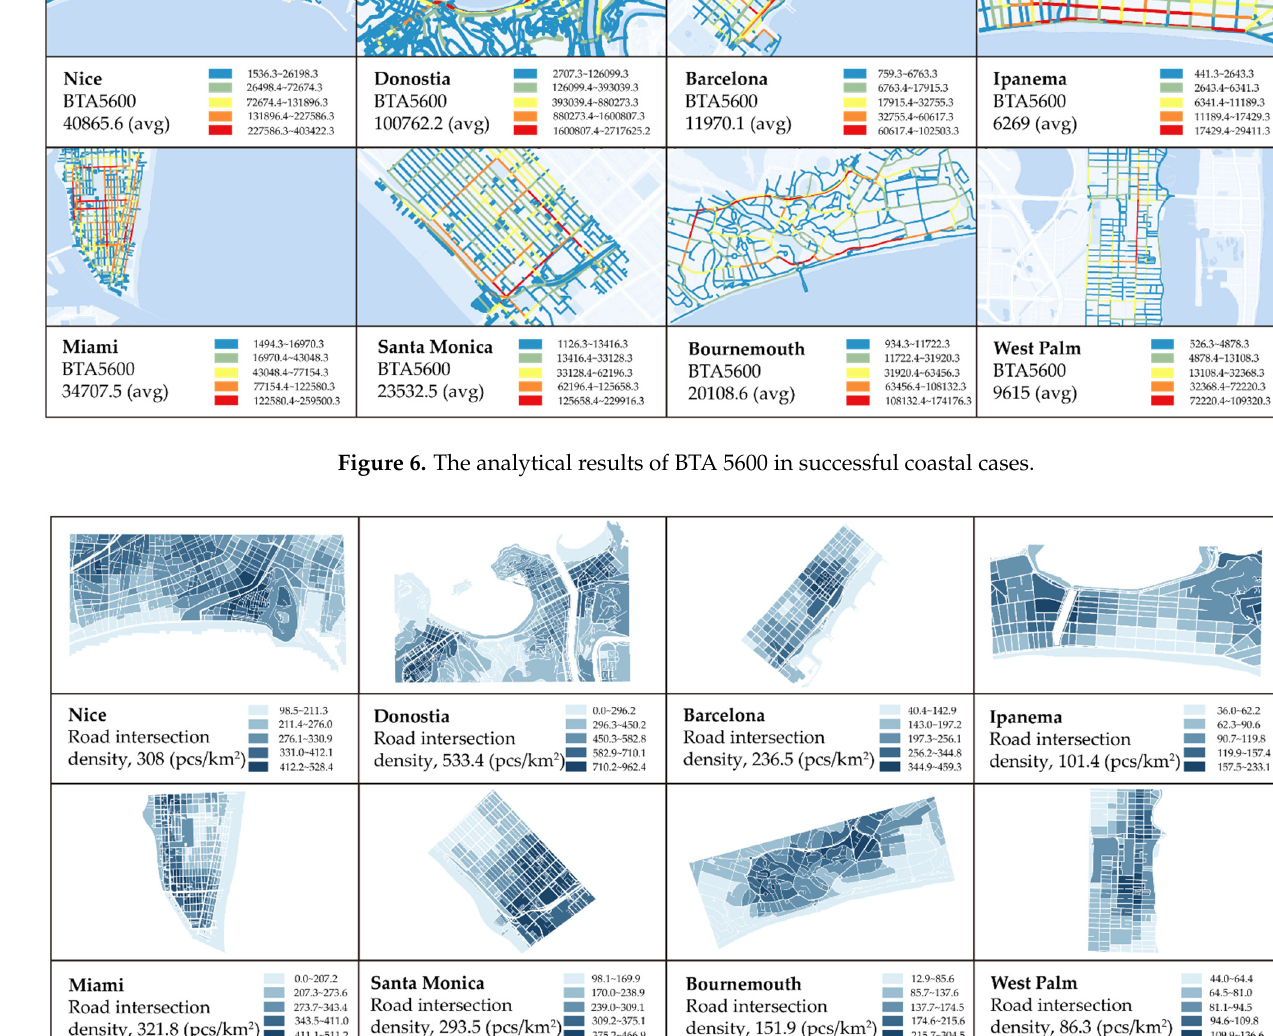
Figure 8. The visualization results of average block size in successful coastal cases. 4.1.2. Typology and Development Intensity The spatial matrix method can be used to quickly learn the dominant building types and their composition methods in each block in the coastal area [36,37]. According to the previous understanding of building types and urban vibrancy [24], as highlighted in Table 2, building types can be categorized into low, medium, and high vibrancy forms, depend ‐ ing on their level of urban vibrancy.